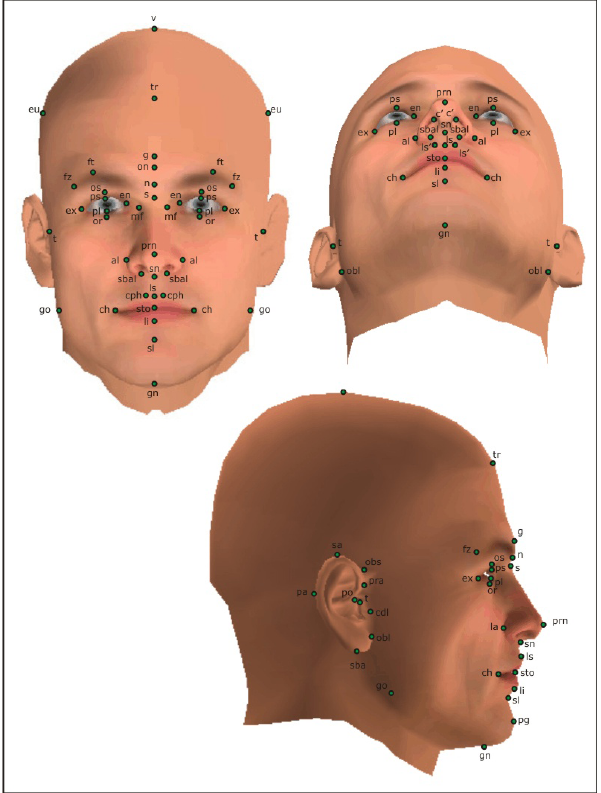
Figure 2. Some facial